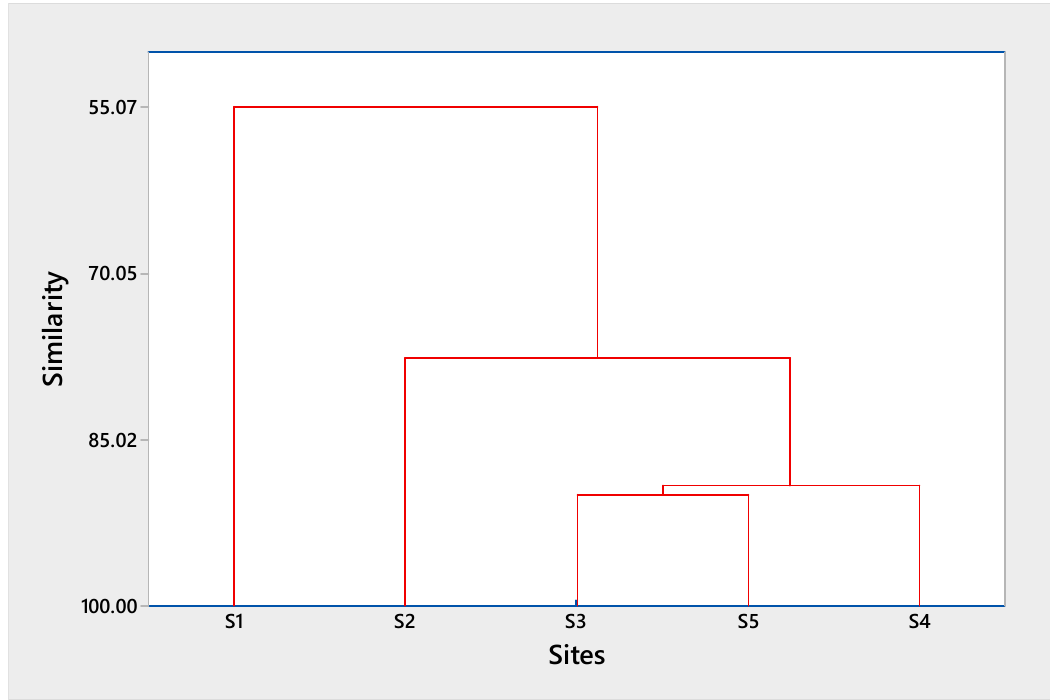
Figure 4. Cluster analysis base on metallic concentrations in sites with the number of similarity distances and levels for clusters.